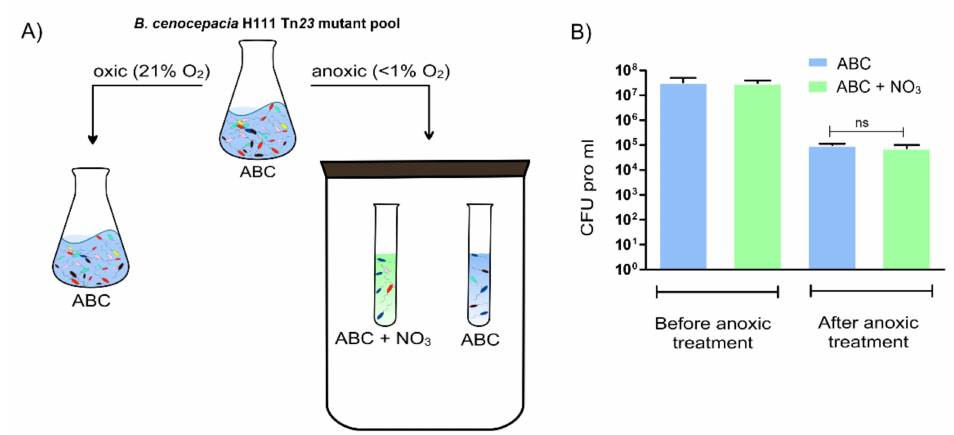
Figure 1. Overview of the preparation of the B. cenocepacia H111 samples used for Tn-seq analysis. ( A ) The B. cenocepacia Tn 23 mutant library was used to inoculate the control sample (grown aerobically until an OD 600 of 0.5 at 37 ◦ C in ABC) and the test samples (anoxically for 5 days at 37 ◦ C in ABC or ABC with 10 mM NaNO 3 ). Control and test samples were prepared for Tn-seq analysis, as described in Material and Methods. Different bacterial mutant strains are indicated with different colors.